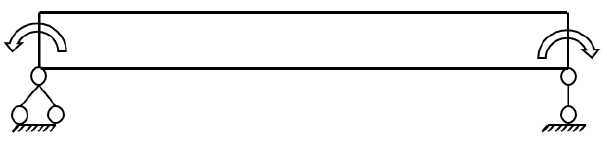
Figure 6. Boundary conditions of bending condition.